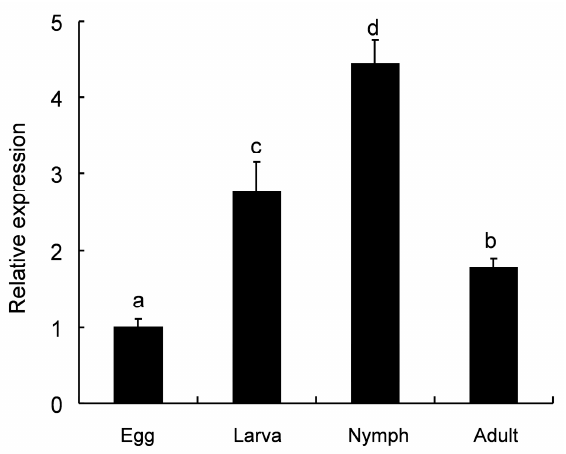
Figure 4. Expression levels of the plasma membrane Ca 2+ -ATPase 1 gene ( TcPMCA1 ) at different developmental stages of Tetranychus cinnabarinus were evaluated using Real-time Quantitative polymerase chain reaction (RT-qPCR). The egg, larval, nymphal, and adult stages were analyzed. Relative expression was calculated according to the value of the lowest expression level, which was assigned with an arbitrary value of 1. Letters above the bars indicate significant differences among different developmental stages. RPS18 was used as reference gene. Data were presented as the means ( ± SE) of three biological replications per developmental stage. Different letters on the error bars indicate significant differences revealed by ANOVA test ( p < 0.05).